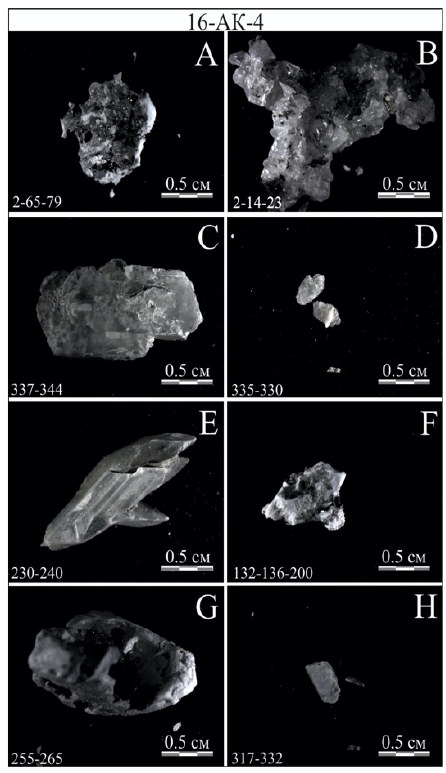
Figure 3. The photos of salt crystals found in sediments.